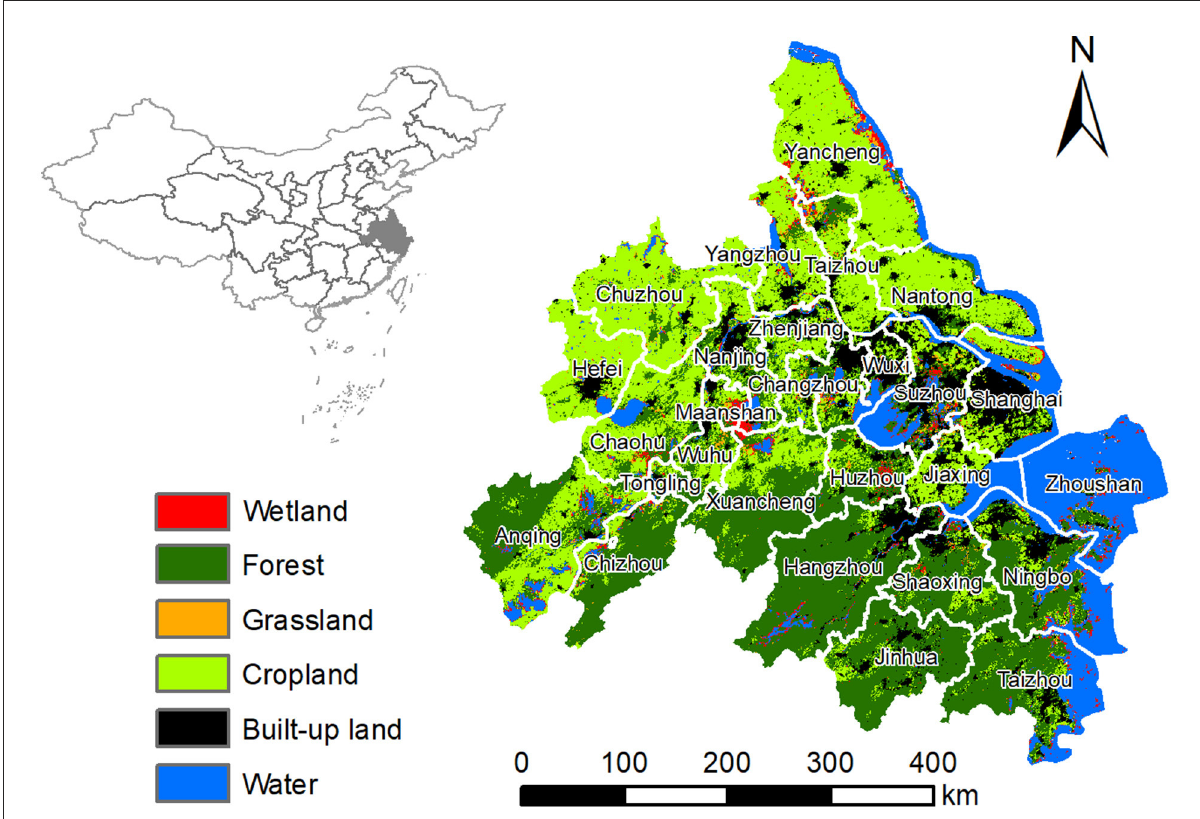
FIGURE1 The location and main land-use types of the study region. The urban land cover map was derived from MCD12Q1 with a spatial resolution of